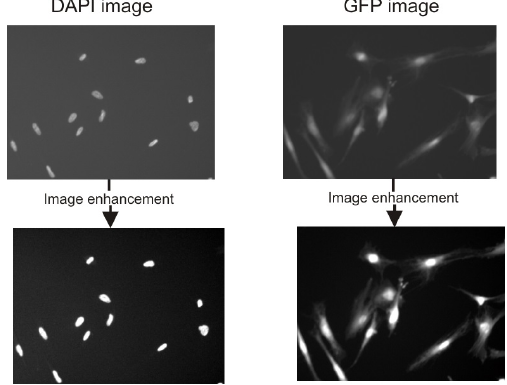
Figure 5. Outcome of the preprocessing step. The image quality is improved, and nuclei and cell areas become more